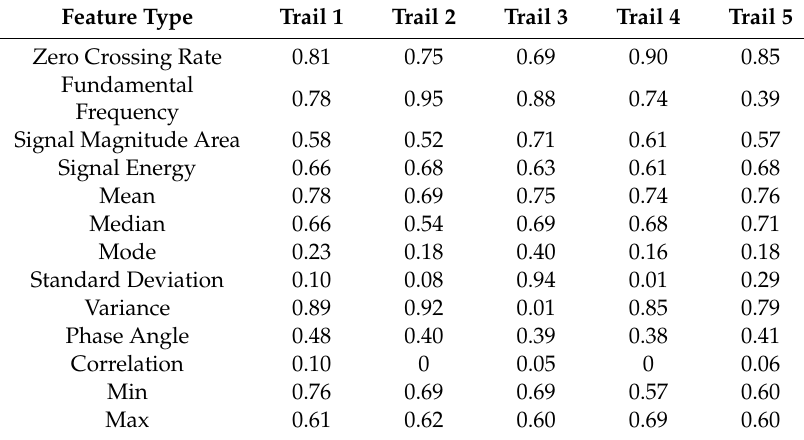
Table 6. Feature weights for di ff erent trails in the WISDM dataset. Feature